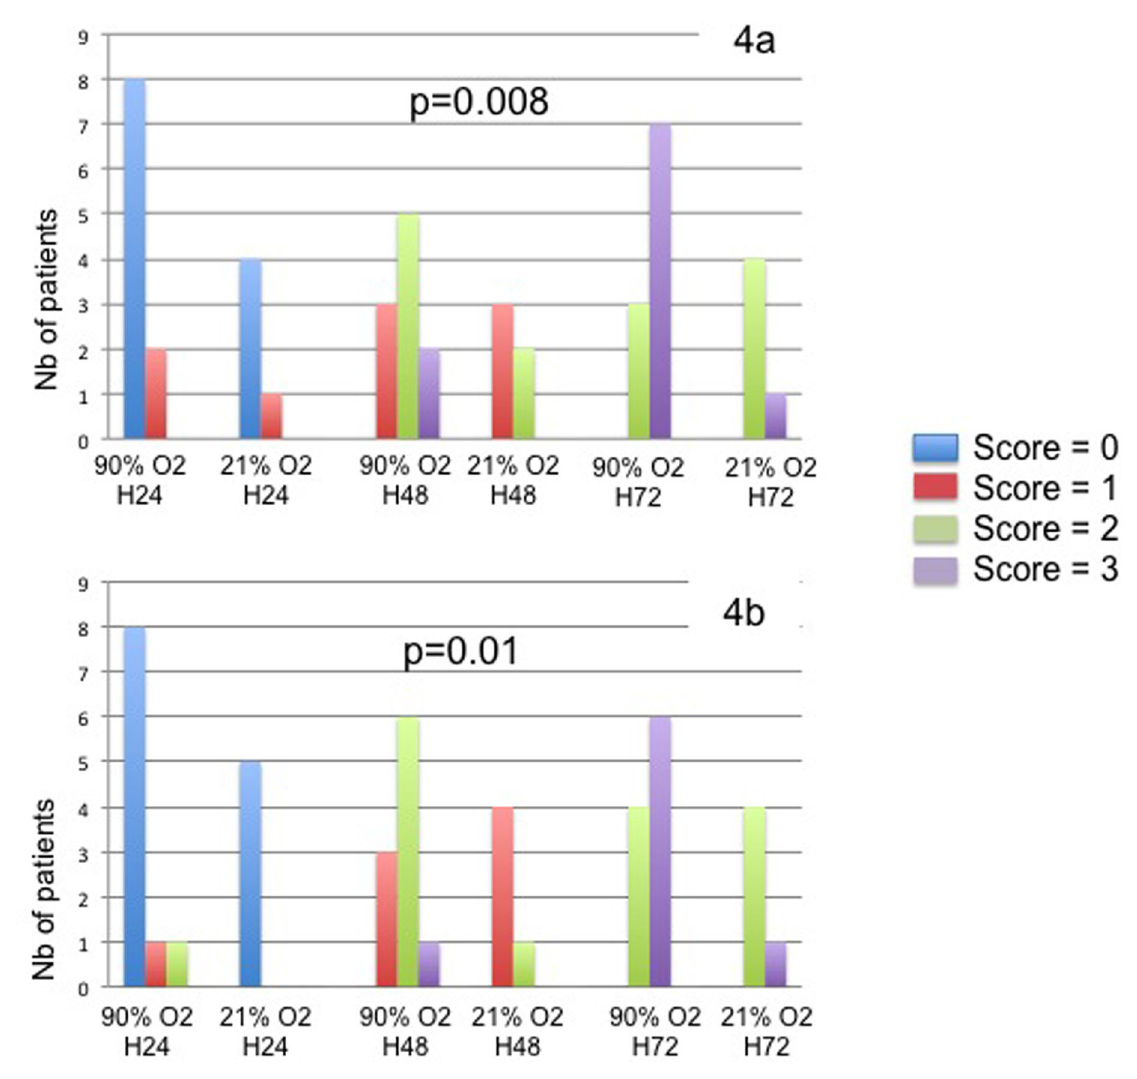
Figure 4. Expression of the CA9 (4a) and the HIF-1α (4b) in acinar cells under hyperoxic and normoxic conditions of culture. The intensity of staining was evaluated as negative scored as 0, weak scored as 1, moderate scored at 2 and strong scored as 3. Results are expressed as the number of cases for each category of the